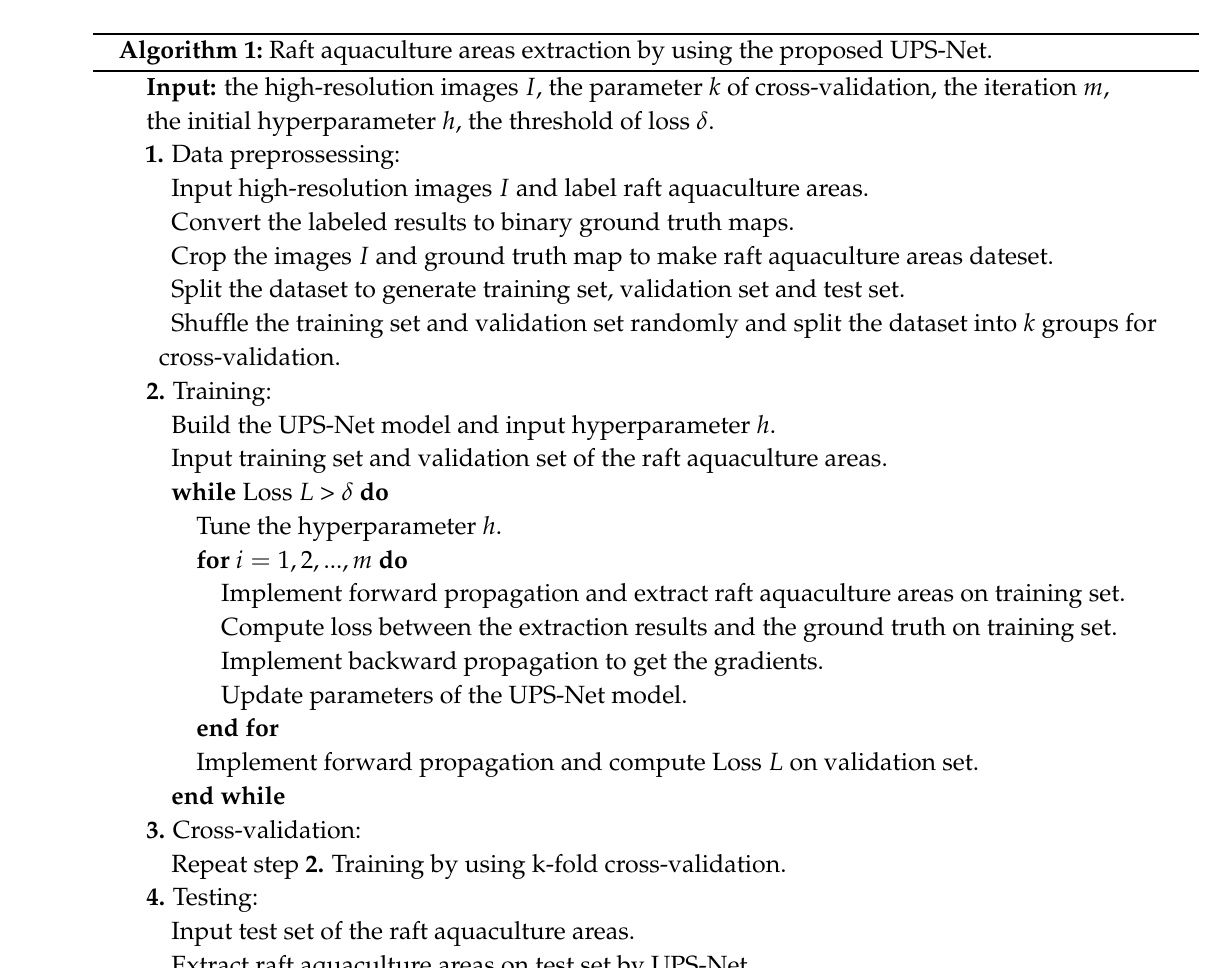
Algorithm 1: Raft aquaculture areas extraction by using the proposed UPS-Net.